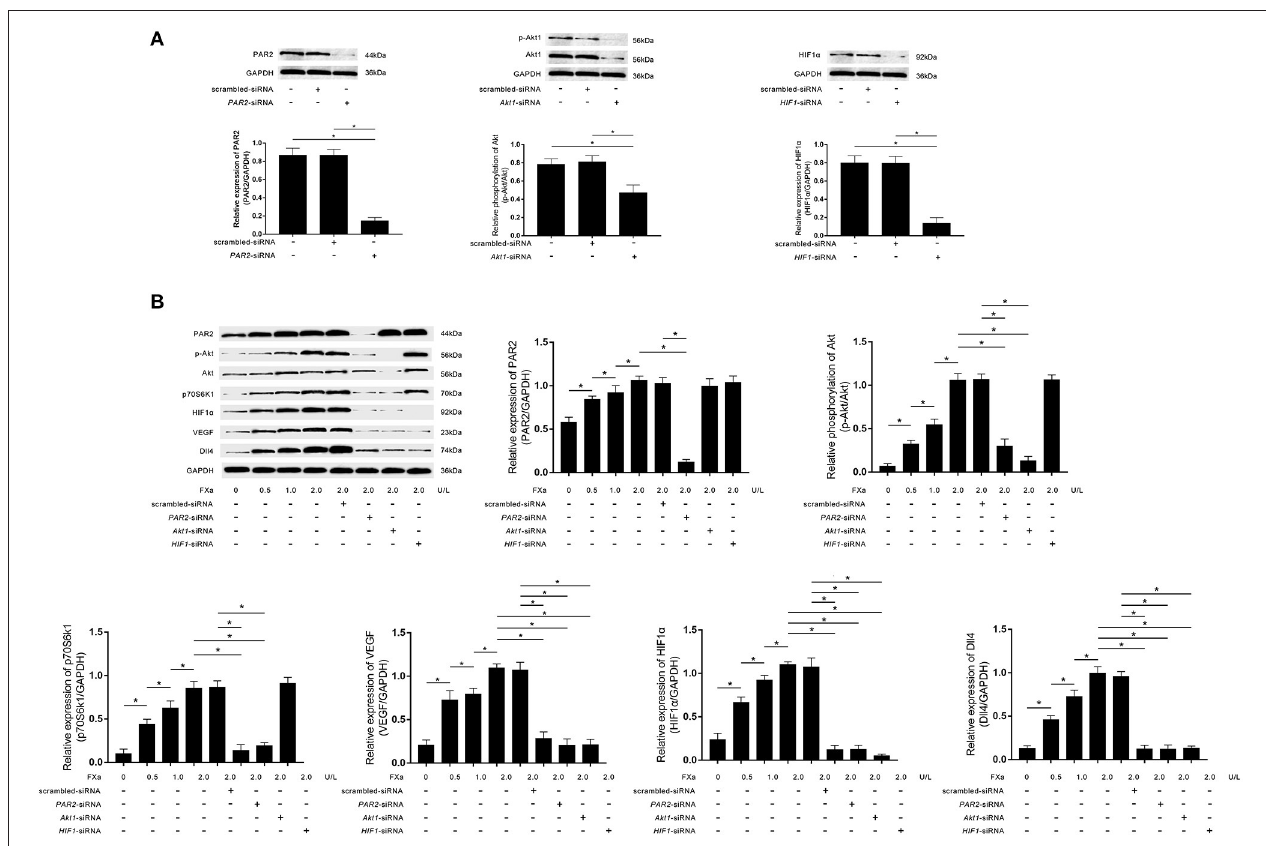
FIGURE 3 | (A) Immunoblots of PAR2, phosphorylated Akt1 (p-Akt), Akt1, HIF1 α , and GAPDH. Columns indicate the relative expression levels of PAR2 and HIF1 α as well as the relative phosphorylation level of Akt in macrophages transfected with PAR2 -siRNA, HIF1 α -siRNA, and Akt1 -siRNA, respectively. (B) Immunoblots of PAR2, p-Akt, Akt, p70S6K1, HIF1 α , VEGF, Dll4, and GAPDH. Columns indicate the relative expression levels of PAR2, p70S6K1, HIF1 α , VEGF, and Dll4, as well as the relative phosphorylation level of Akt in macrophages exposed to FXa at 0, 0.5, 1.0, and 2.0 U/L. Macrophages treated with FXa at 2.0 U/L were also transfected